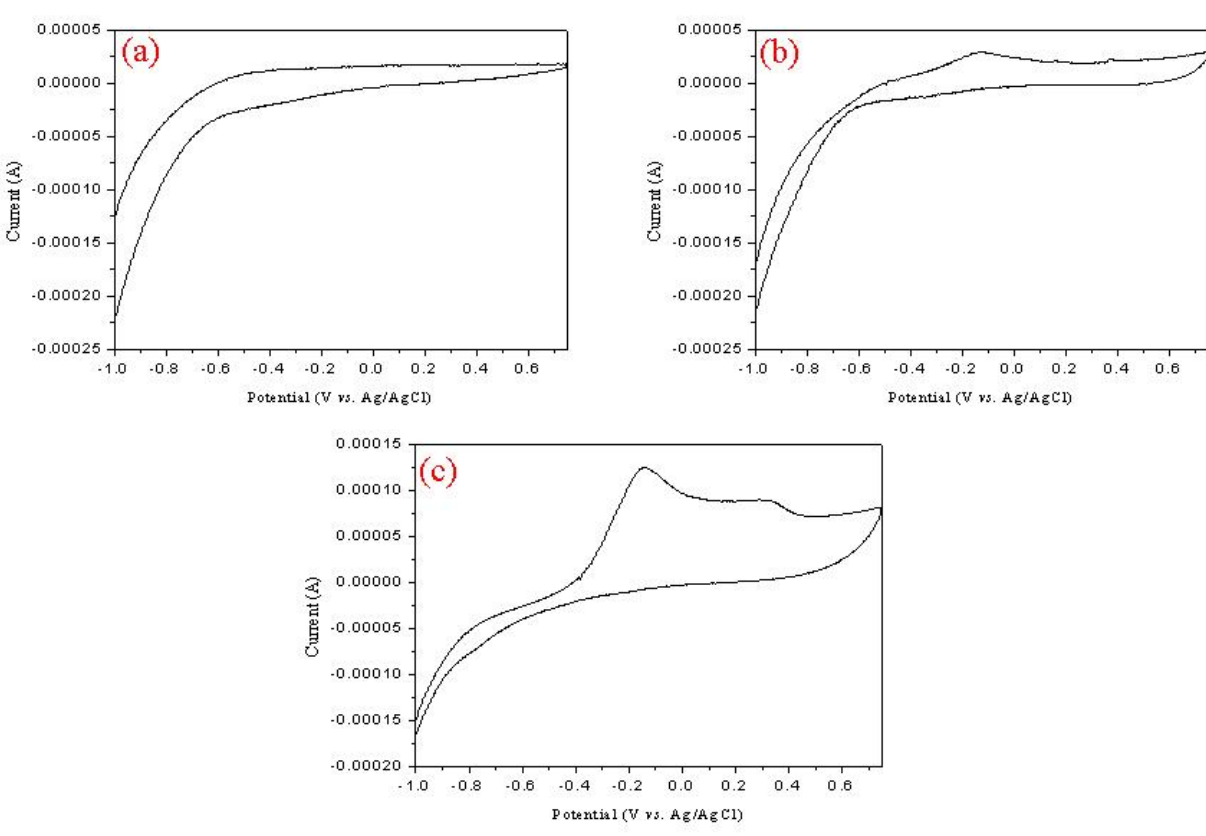
Figure 5. Cyclic voltammograms of phenol on the pure MWNT electrode with tyrosinase (a), chitosan electrode with tyrosinase (b), and MWNT ion liquid electrode with tyrosinase (c) in 2.0 mL phosphate buffer solution (pH =